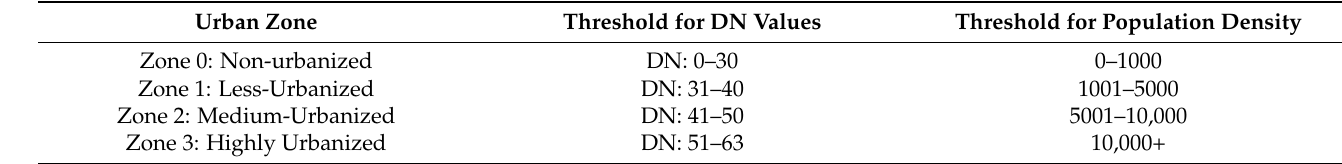
Table 1. Thresholds for Nighttime Light and Gridded Population